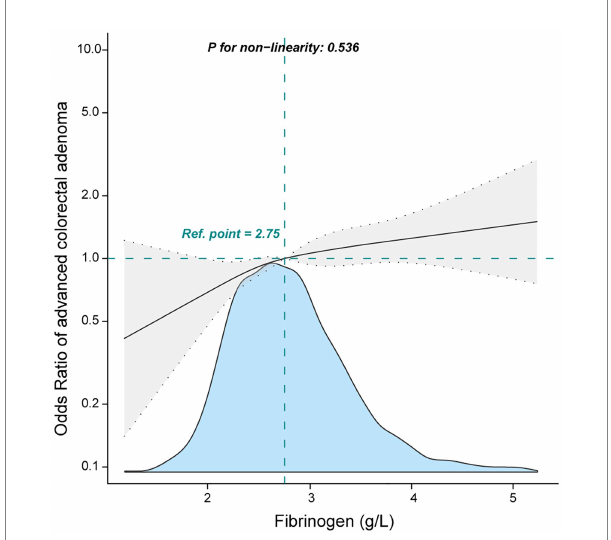
FIGURE 2 Association between fibrinogen and advanced colorectal adenoma among inpatients. They were adjusted for age, sex, albumin, alkaline phosphatase, creatinine, platelets, activated partial thromboplastin time, hypertension, and diabetes